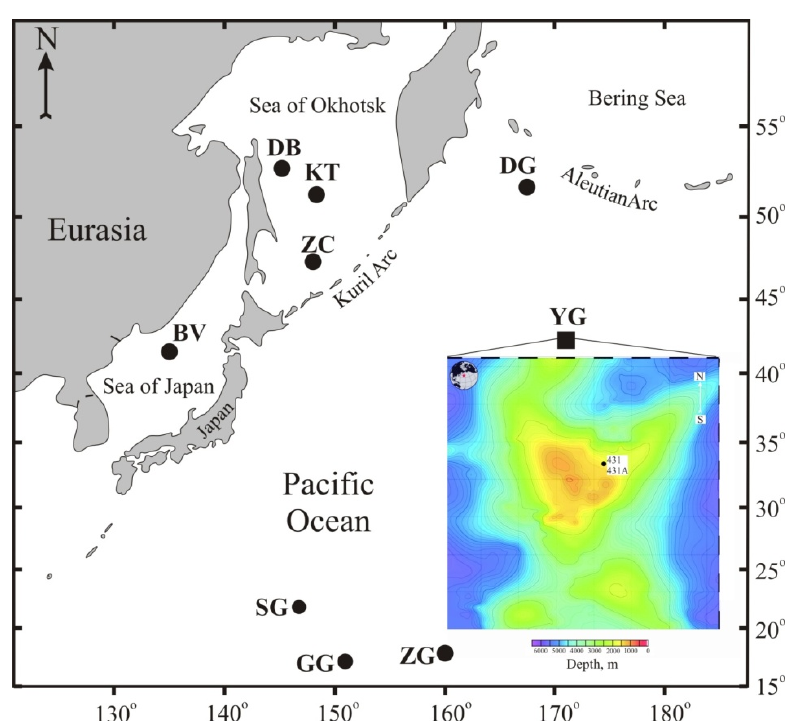
Figure 1. Scheme location of Y¯omei Guyot and other seamounts and Y¯omei Guyot bathymetry [24] with location of Holes 431 and 431A DSDP (insert). YG—Y¯omei Guyot, DG—Detroit Guyot, GG—Govorov